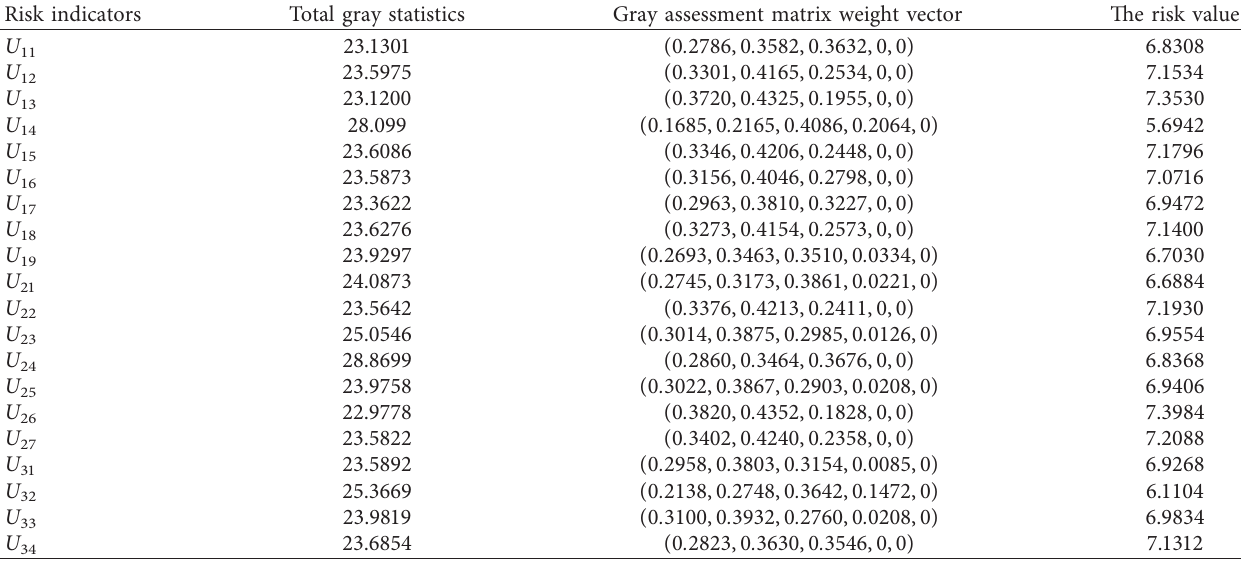
Table 9: The total calculation results.